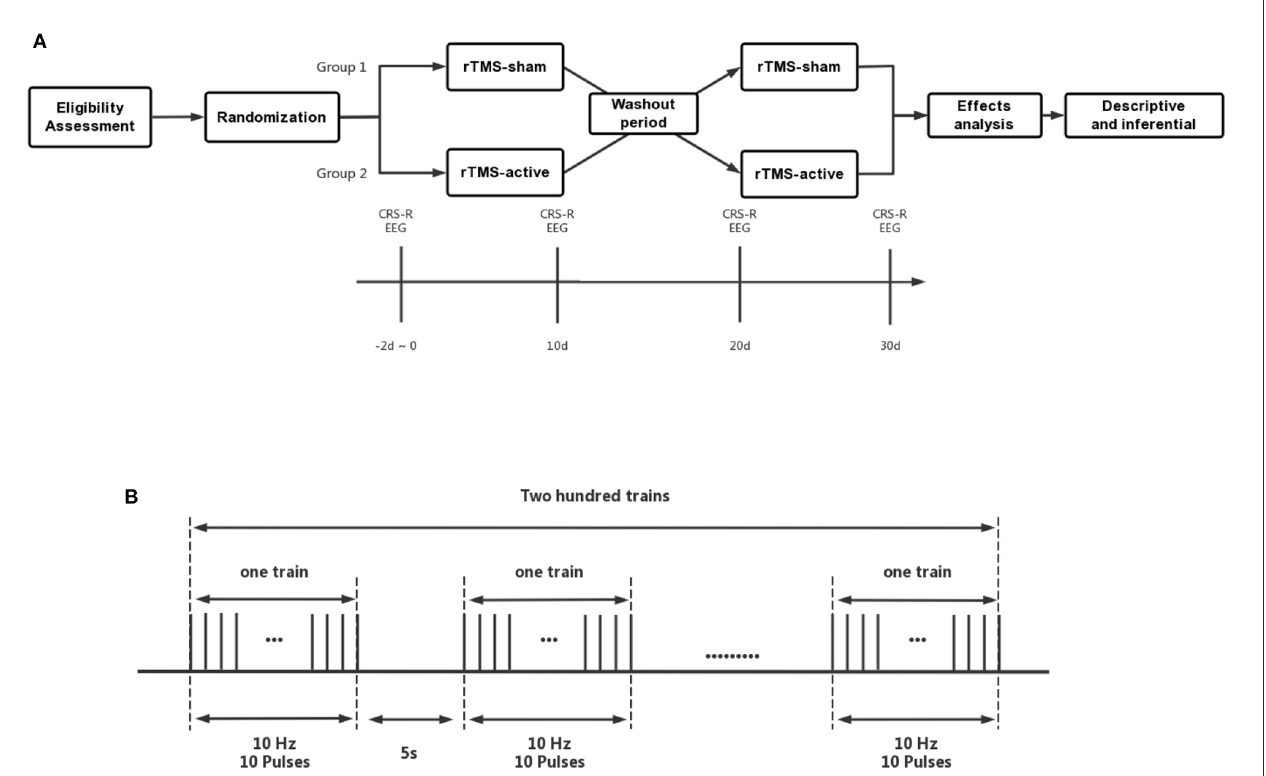
FIGURE1 (A) The crossover, randomized, double-blind, sham-controlled study protocol, (B) Details of rTMS parameters. CRS-R, Coma Recovery Scale-Revised; EEG, Electroencephalogram; rTMS-a, rTMS-active; rTMS-s,